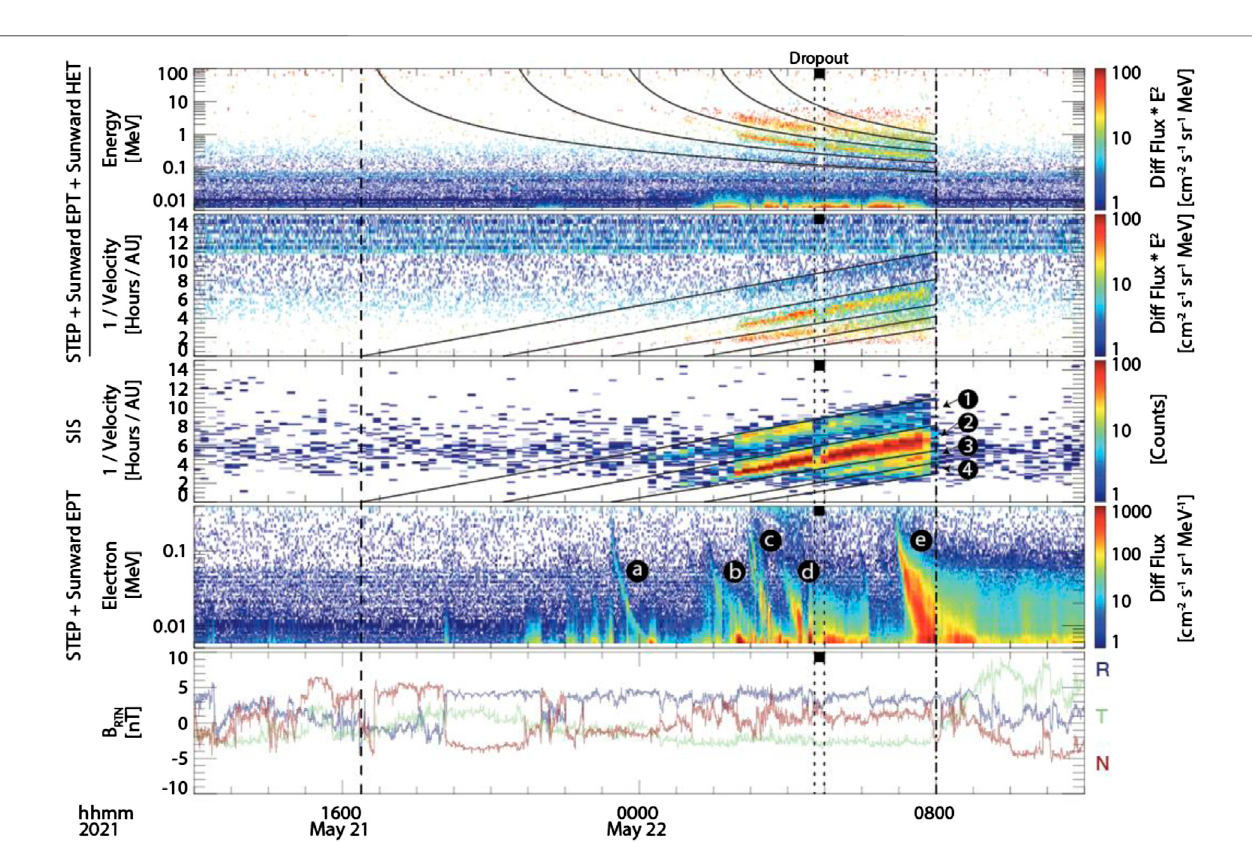
FIGURE3| Detailed EPD observations duringthe fi rstfour 3 He-rich events. Theformat issimilar to Figure 2 but with theSISmassspectrogram panel replaced by the EPD electrons in panel 4. The dropout periods are identi fi ed by dashed lines and label.